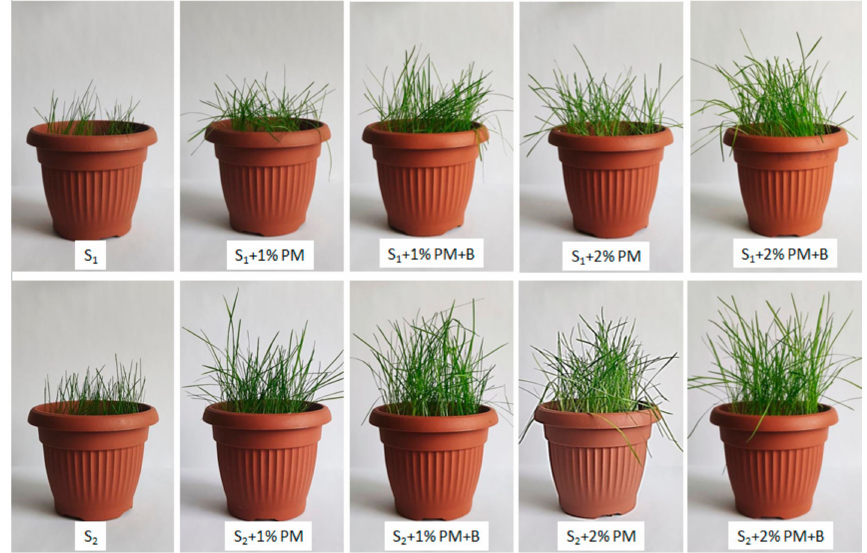
Figure 5. Pot samples with the grass seed mixture after 21 days of plant growth.